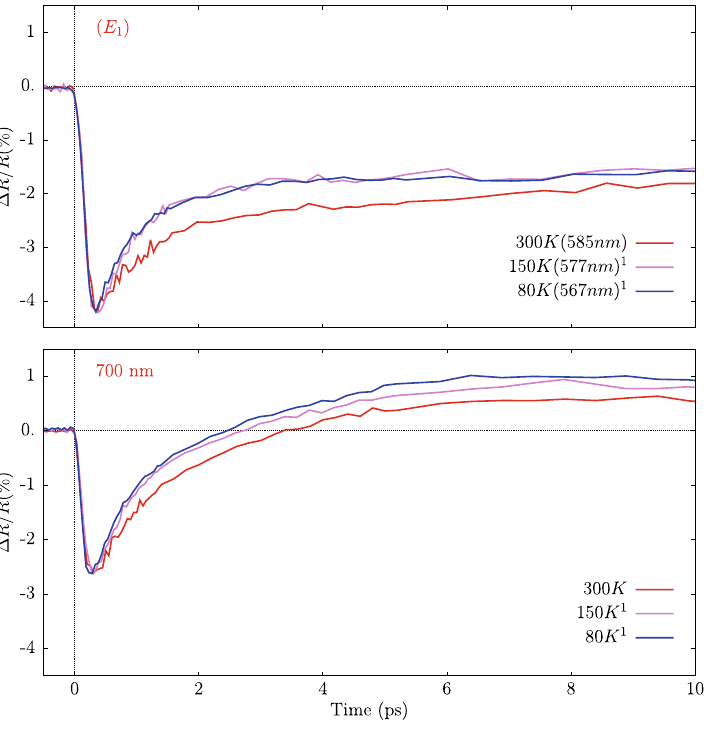
Figure 6. Transient reflectivity spectra of germanium (fluence 16 mJ/ cm 2 ) collected at different sample temperatures and at selected wavelengths: those corresponding to the E 1 singularity (top) and at 700 nm (bottom). 1 : normalized to the minimum � R / R value at 300